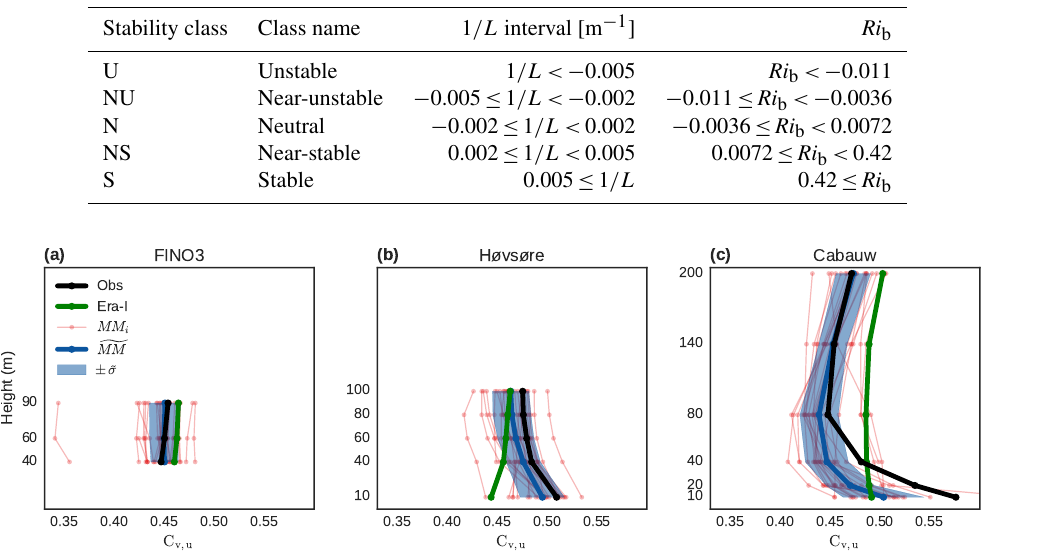
Table 2. Ranges of inverse Obukhov length (1 /L ) and bulk Richardson number ( Ri b ) used in the stability classification. The 1 /L classes were used in Gryning et al. (2007) and the Ri b classes in Mohan and Siddiqui (1998). In both cases the original very unstable and the stable classes have been combined into the open-ended stable class. The same is true for the original very unstable and unstable classes, which have been combined into the open-ended unstable class.